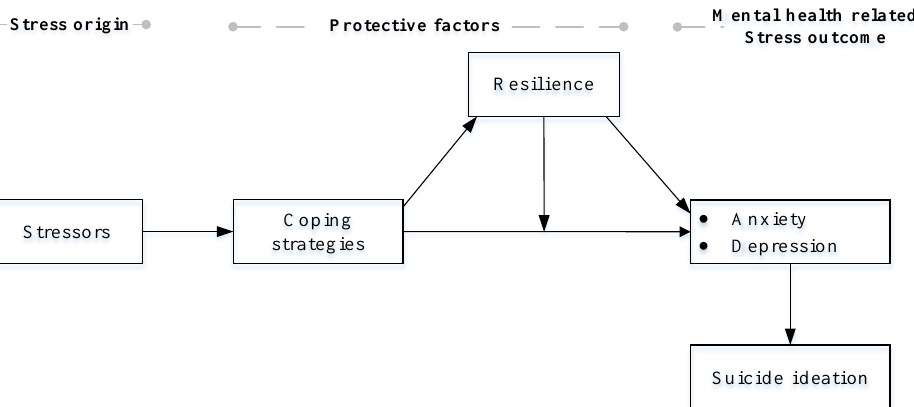
Figure 1. The Stress-Coping-Resilience framework (Adapted from Nwaogu [43]).